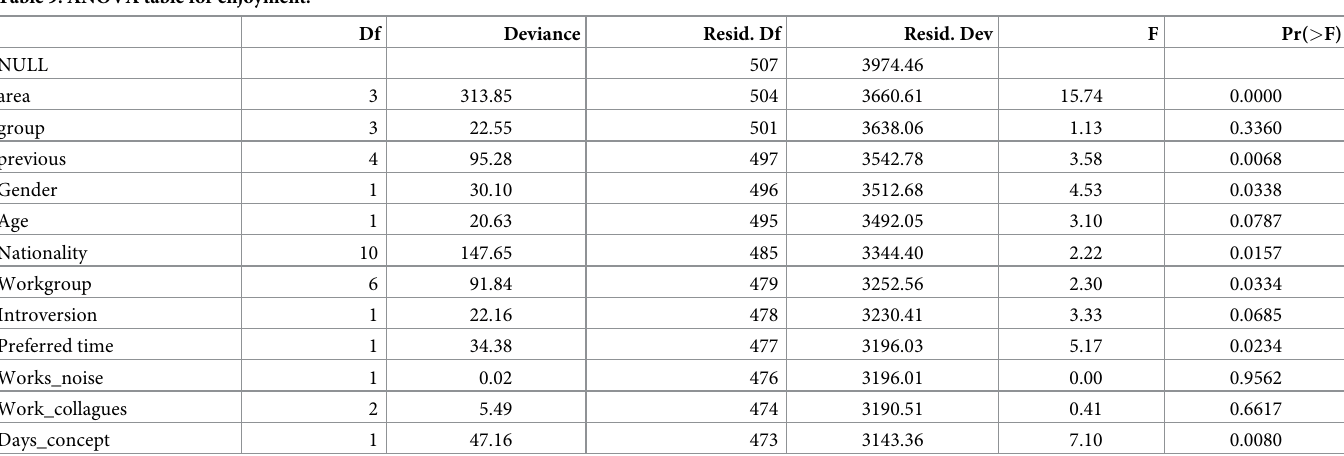
Table 9. ANOVA table for